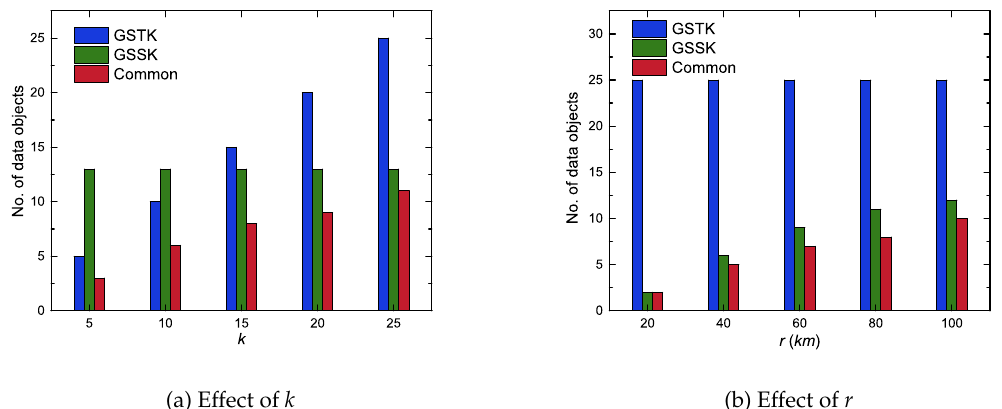
Figure 14. The number of data objects returned by GSTK and GSSK